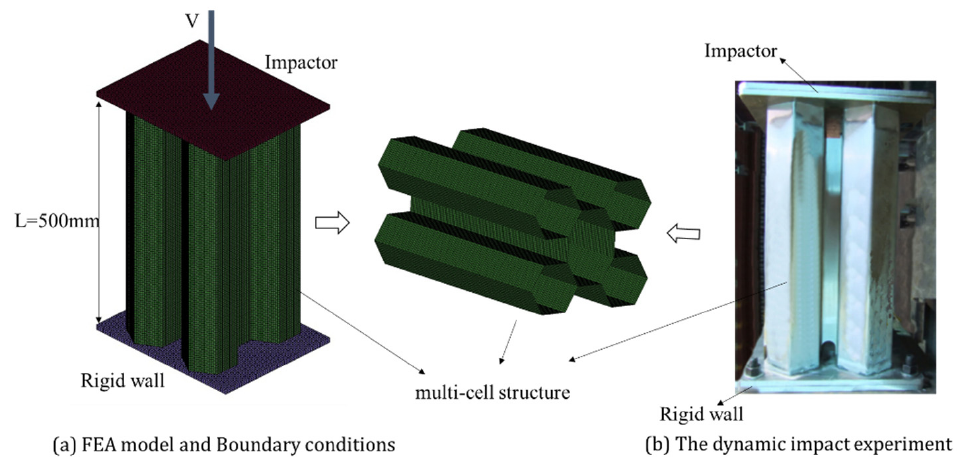
Figure 3. FE model and impact test of multi-cell structure. ( a ) FEA model and Boundary condi- tions; ( b ) The dynamic impact experiment.